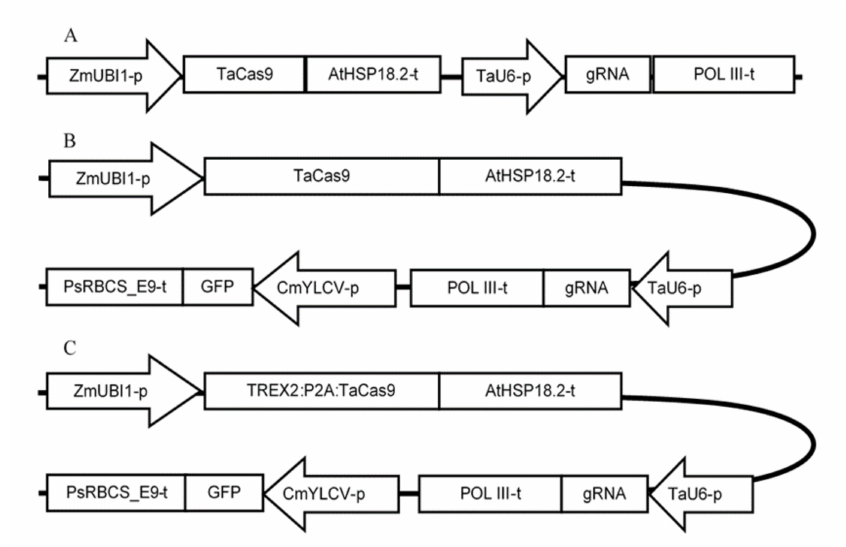
Figure 2. Schematic illustration of the cas9 and gRNAs expression cassettes in ( A ) the transient expression vector used for the barley transformation experiment, and a binary vectors lacking ( B ) or containing ( C ) TREX2 nuclease sequence used for protoplast transformation. TaU6-p— Triticum aestivum U6 pro- moter, POL III-t— RNA POLYMERASE III terminator, CmYLCV-p—strong constitutive promoter from Cestrum yellow leaf curling virus , GFP—sequence of GREEN FLUORESCENT PROTEIN gene, ZmUBI1- p—Zea mays POLYUBIQUITIN 1 promoter, gRNA—single guide RNA scaffold, PsRBCS_E9-t—pea RIBULOSE BISPHOSPHATE CARBOXYLASE SMALL SUBUNIT terminator, TaCas9— Triticum aestivum codon-optimized CRISPR-associated protein 9 , AtHSP18.2-t— Arabidopsis thaliana HEAT SHOCK PROTEIN